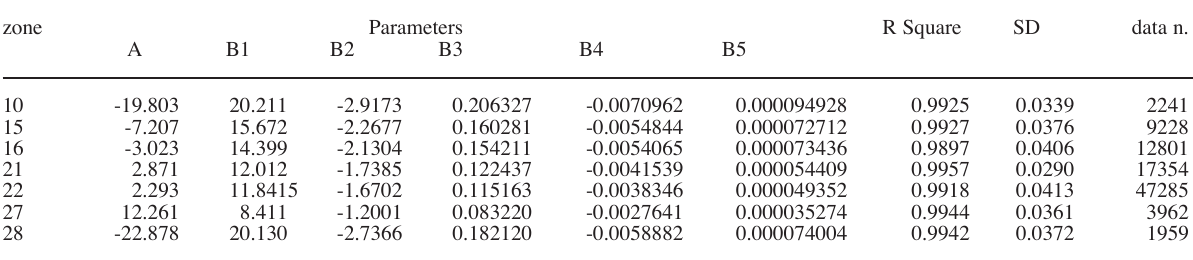
·T + B ·T 2 + B ·T 3 + B ·T 4 + B ·T 5 for each of the 2º x 2º zones in the Canary 1 2 3 4 5 deviation, are